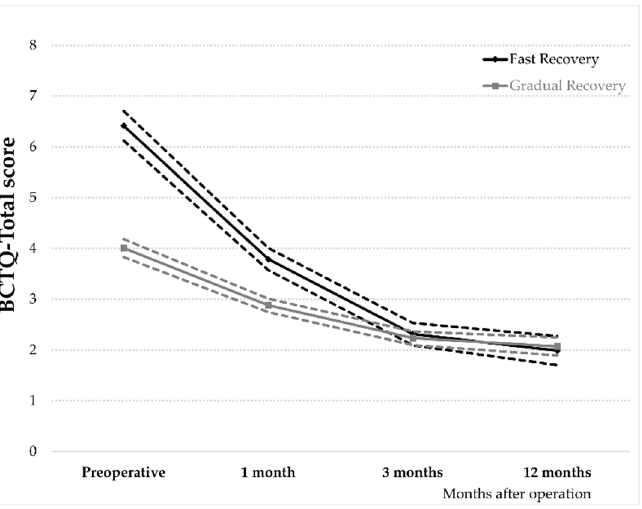
Figure 2. The trajectories and 95% confidence intervals of the perioperative recovery pattern of the Boston Carpal Tunnel Questionnaire (BCTQ)-Total scores after percutaneous ultrasound-guided carpal tunnel release.